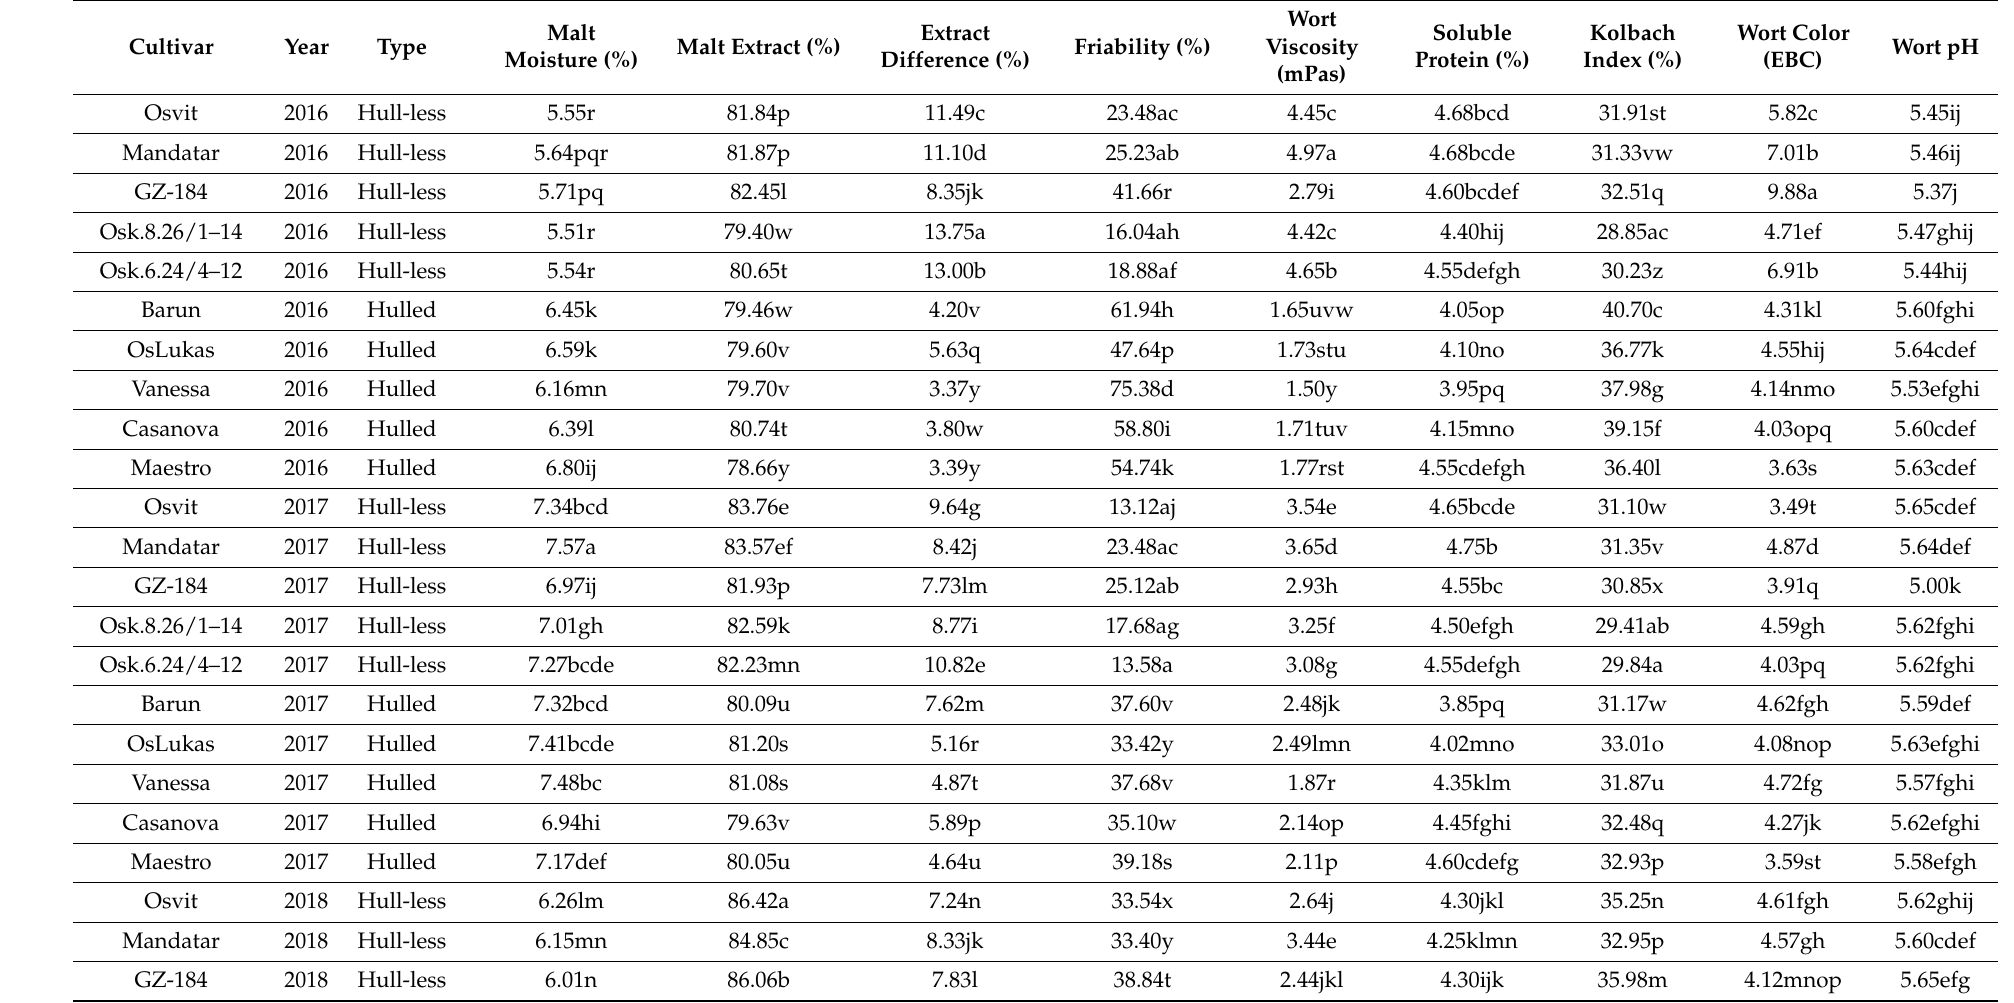
Table 2. Malt quality